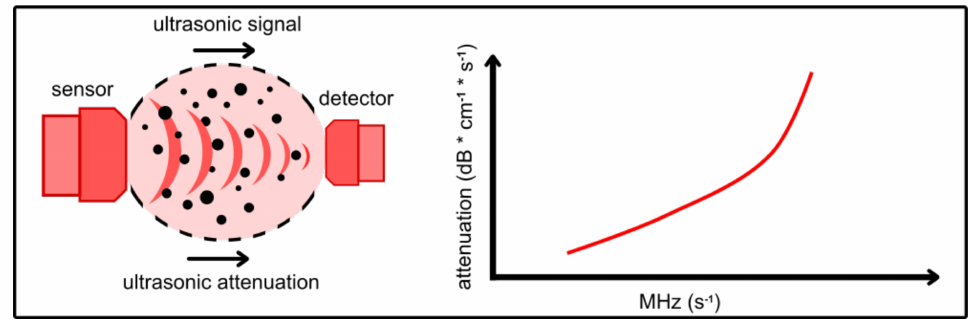
Figure 5. Ultrasonic attenuation. The sensor setup is shown on the left, with ultrasonic signal and attenuation, and the attenuation signal is shown on the